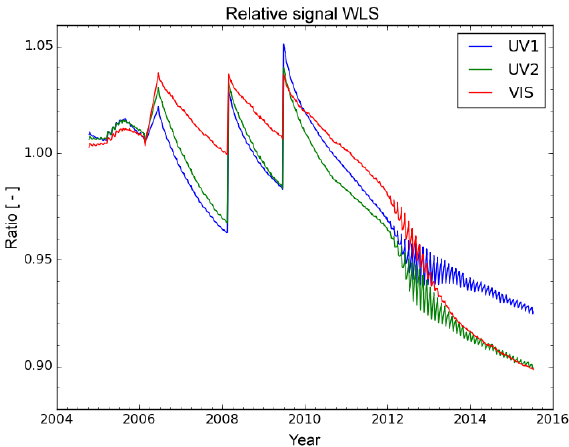
Figure 6. Signal change of LED during the mission. Each data point shows a measurement divided by a reference measurement from the beginning of the mission.